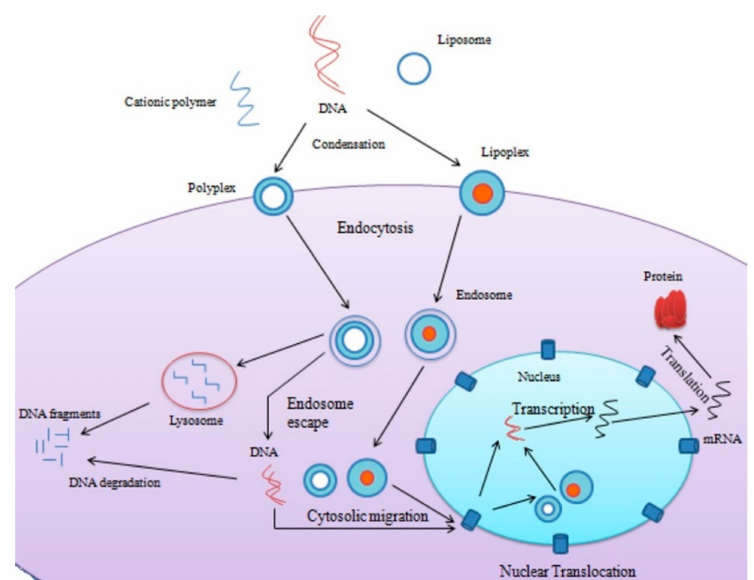
Figure 3. Basic mechanism of non-viral gene delivery via polyplex and